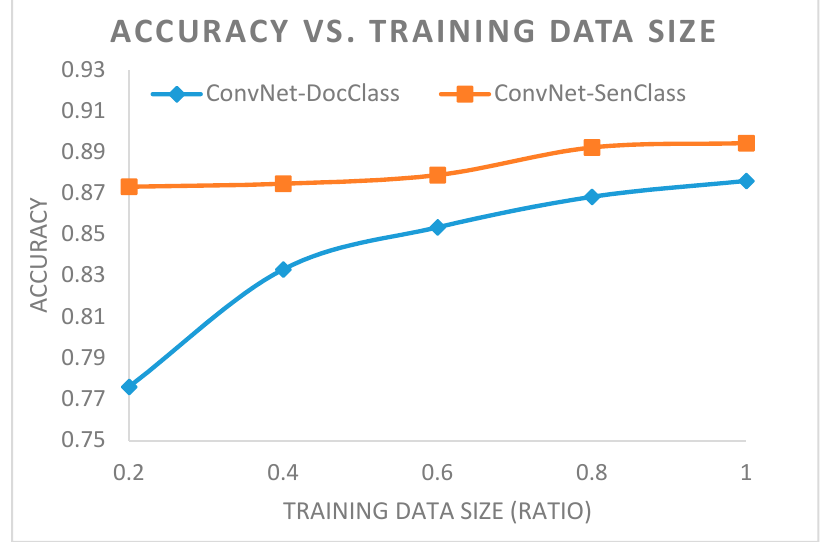
Figure 5. Learning curve.